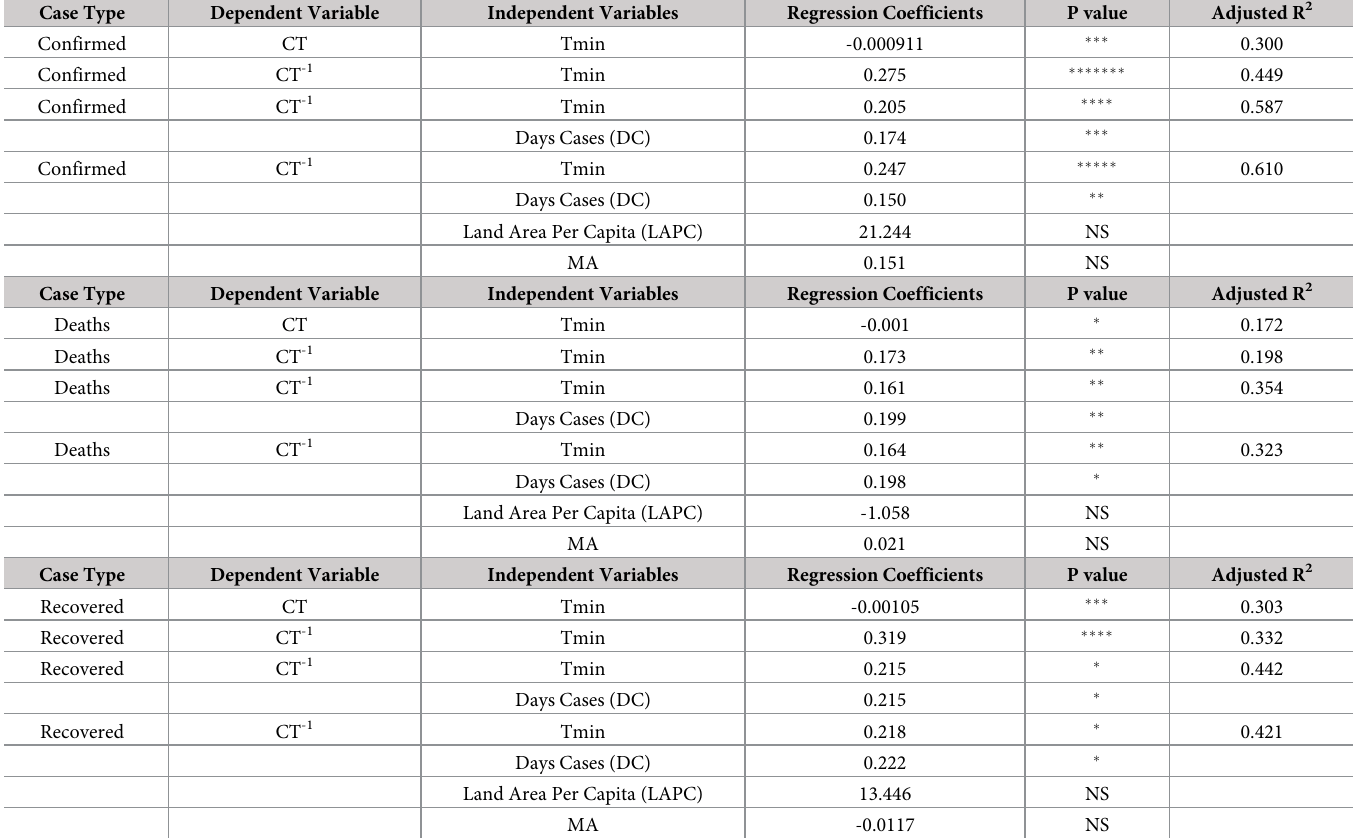
Table 2. Second regression: The association of temperature and dewpoint with the rate of rise of COVID-19 cases. Case